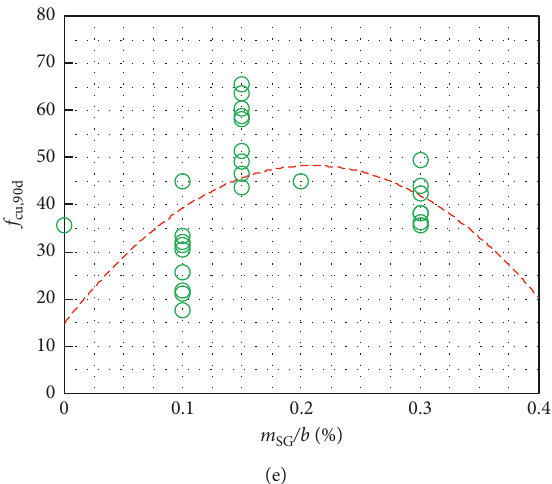
Figure 6: Effect of (m) SG /(b) on (f) cu,N . (a) At 3 days. (b) At 7 days. (c) At 28 days. (d) At 60 days. (e) At 90 days.